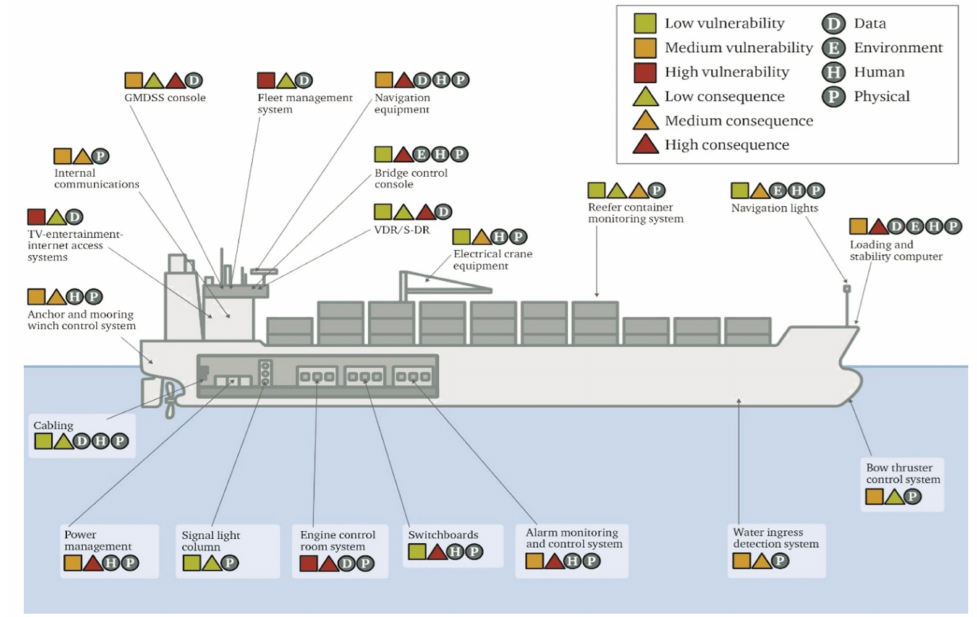
Figure 4. Ship Components (Vulnerabilities, Consequences and Affected Fields) . Note: When two triangles exist, they are introduced to indicate the difference in consequences based on the nature of the cyber incident. Source: